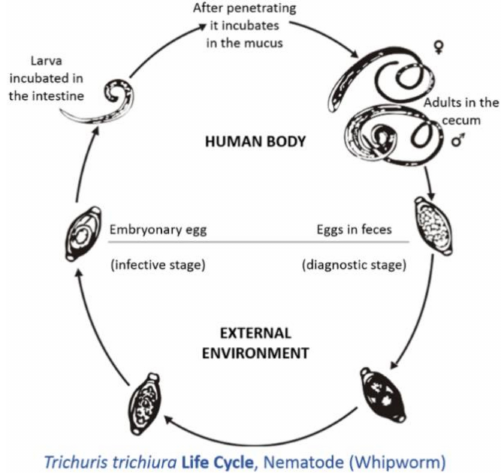
Figure 1. Life cycle of Tichuris trichiura (taken from